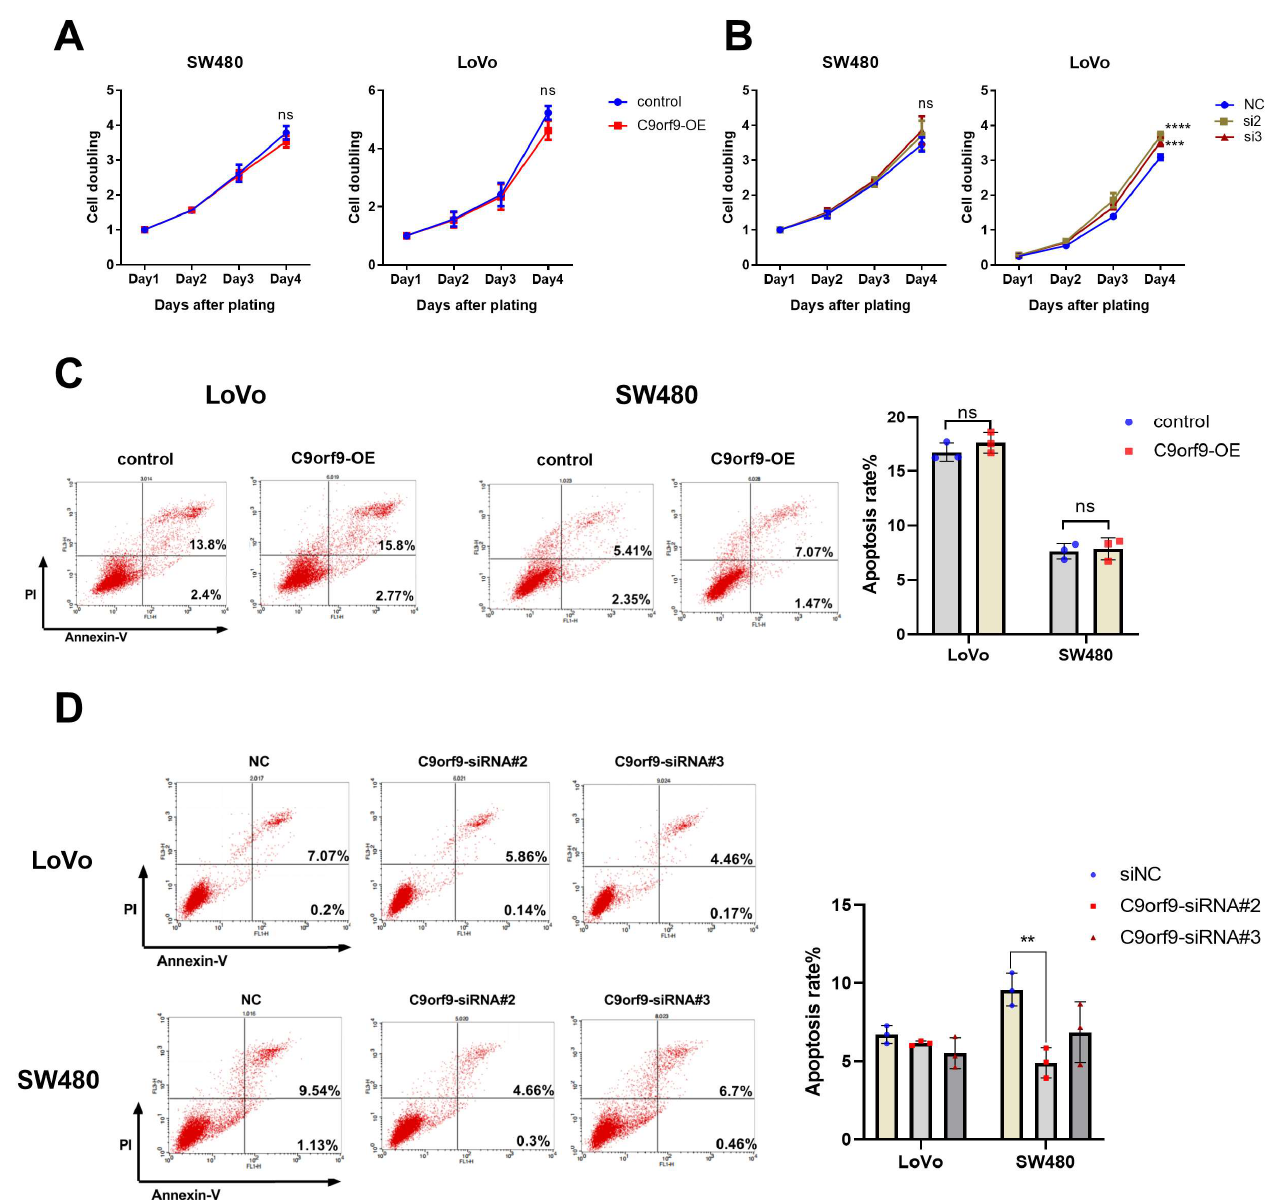
Figure 3. C9orf9 has limit effect on cell growth. ( A ). Overexpression of C9orf9 in SW480 and LoVo cells did not affect cell proliferation. ( B ). Knockdown of C9orf9 slightly promoted cell proliferation in LoVo cells, but not in SW480. ( C ). Cell apoptosis analysis using Annexin/PI double staining in LoVo and SW480 cells transfected with C9orf9 expression plasmid. ( D ). Cell apoptosis analysis using Annexin/PI double staining in LoVo and SW480 cells transfected with C9orf9-specific siRNAs. Ns, not significant, ** p < 0.01, *** p < 0.001, **** p < 0.0001.